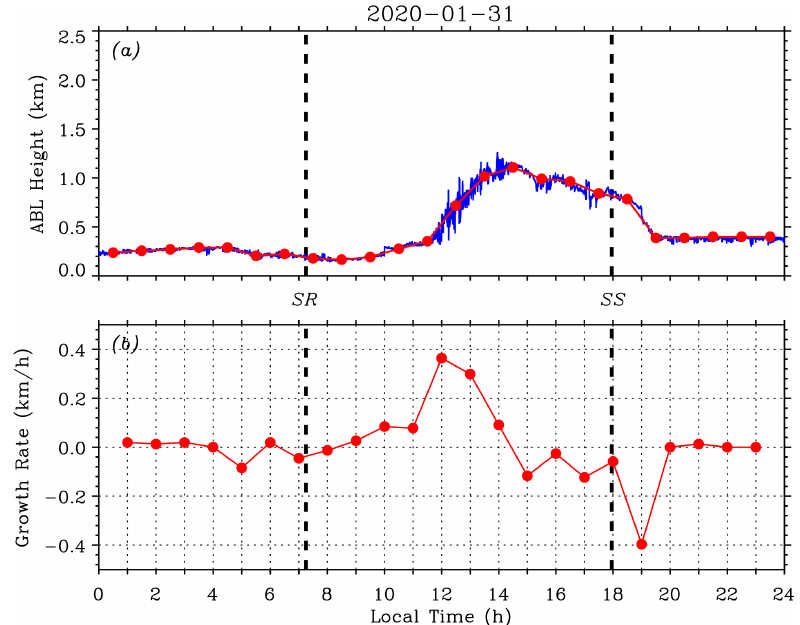
Figure 5. (a) Instantaneous ABL depths (blue) obtained using the LGM method (before 10:00 and after 19:00LT) and HWT method (between 10:00 and 19:00LT). Red solid circles indicate the hourly mean ABL depth from the variance method. (b) Hourly mean ABL depth growth rate. Thick black dashed lines mark the SR and SS times on 31 January 2020.